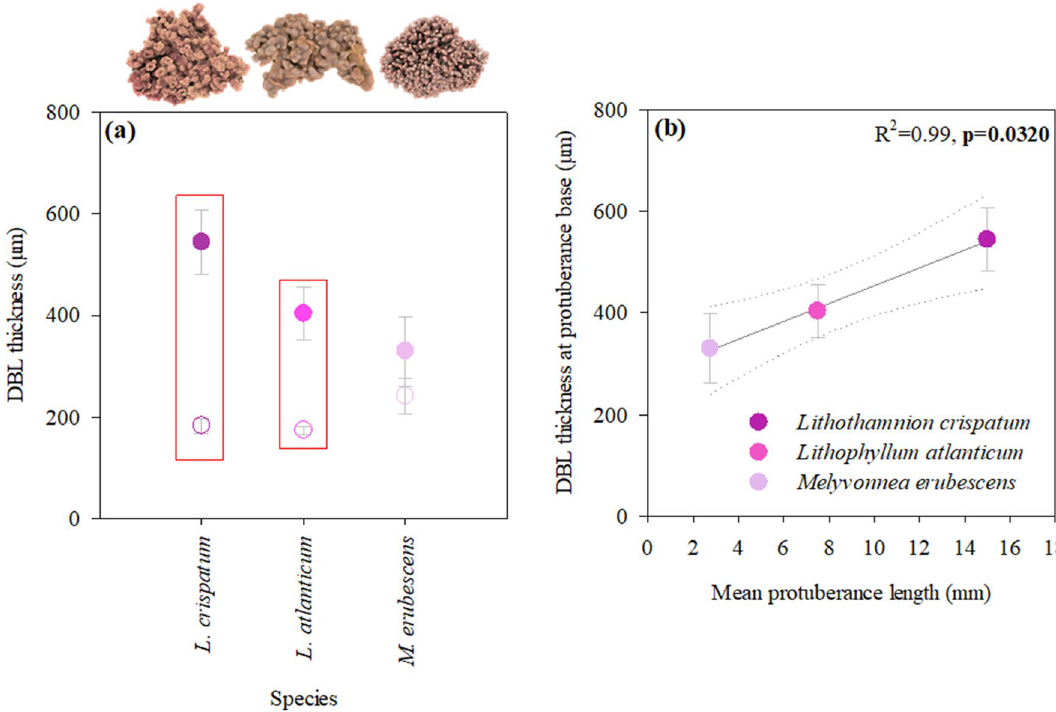
Figure 3. Influence of rhodolith morphology on diffusive boundary layer (DBL) thickness. ( a ) Comparison between DBL thickness at protuberance tips (empty circles) vs. bases (filled symbols) and ( b ) the linear relationship between rhodolith protuberance length (mean reported values) and DBL thickness at the protuberance base (dotted lines represent 95% confidence bands). Data represent mean ± SE (n = 3 per species and location) and red boxes in ( a ) indicate significant differences between tip and base in the respective species (ANOVA, Newman Keuls, p <